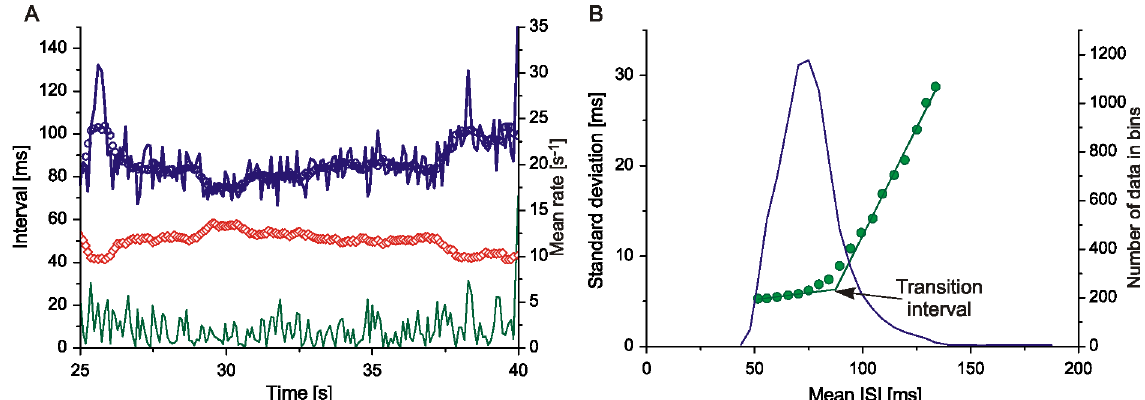
Fig 1. AHP duration estimation. A) an example of data from a control subject: blue line, interspike intervals, blue circles, their moving average, orange diamonds, mean firing rate (inverse of ISI moving average), green line, absolute value of consecutive difference, all plotted vs. time. Note different scale for firing rate (right axis); B) green circles, SD(MISI) plot, lines fitted to the linear fragments of the plot. Their intersection determines the transition interval, which is an estimate of AHP duration (arrow); blue line, number of data in bins, right axis.